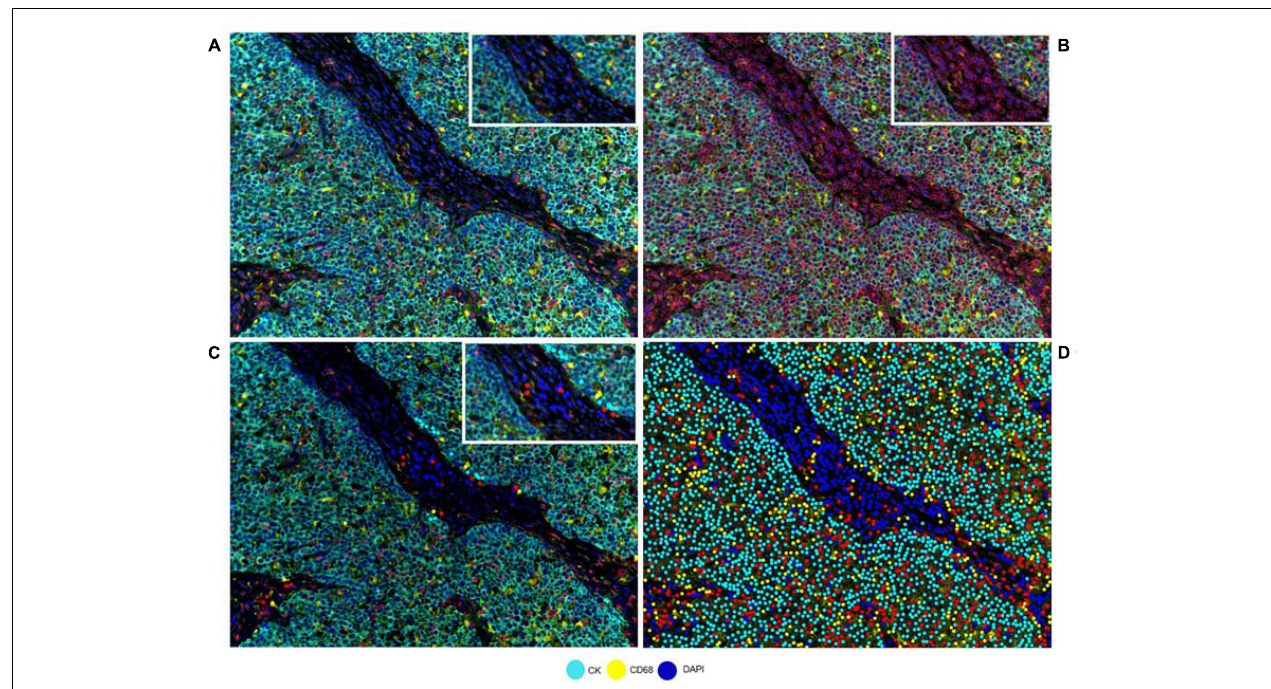
FIGURE 2 | Developing a phenotyping algorithm for an intraductal papillary mucinous neoplasm image. (A) Composite image. (B) Cell segmentation with red lines surrounding the cells. (C) Phenotyping examples. (D) Phenotype result of the software after training. White-framed rectangles on the images identify the same area in the four images, and this area has been amplified in the white-framed rectangles on the upper right of each panel.